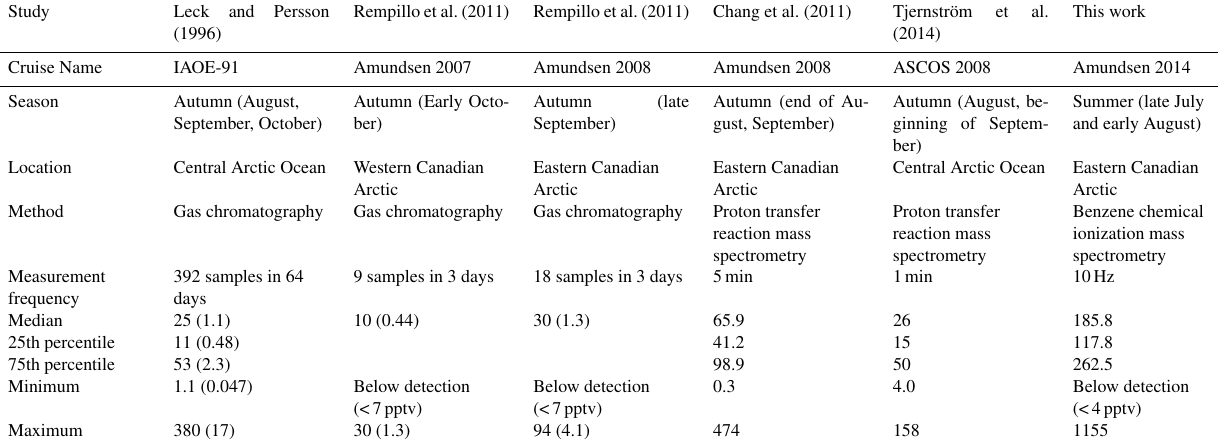
Table 1. Summary of past DMS atmospheric mixing ratio measurements in the Arctic. Study Leck and Persson